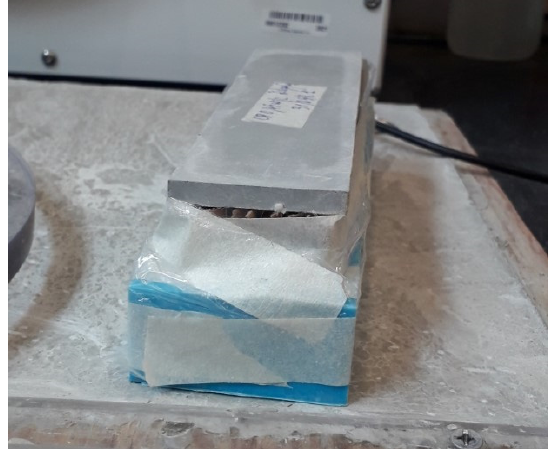
Figure 5. Water-vapor-transmission sample.